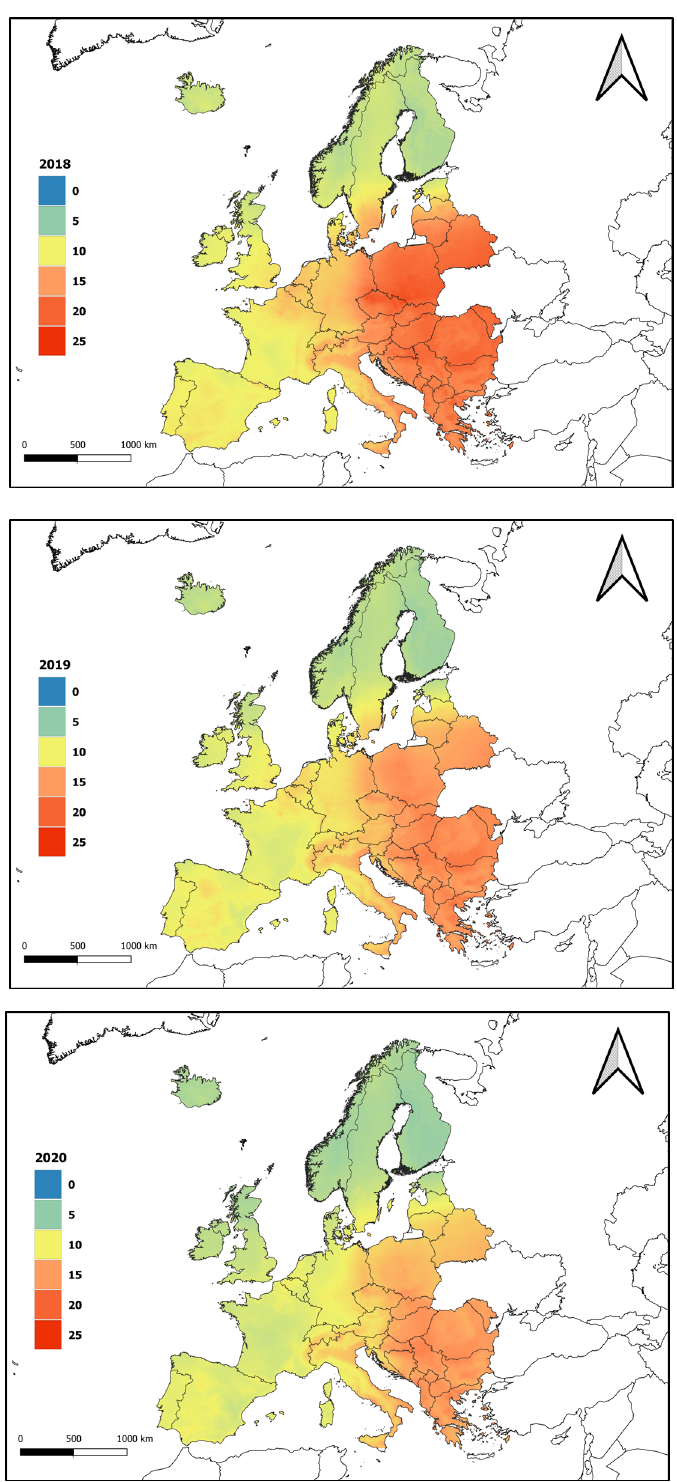
Figure 5. The average PM 2.5 for the years 2018, 2019, and 2020 over Europe.